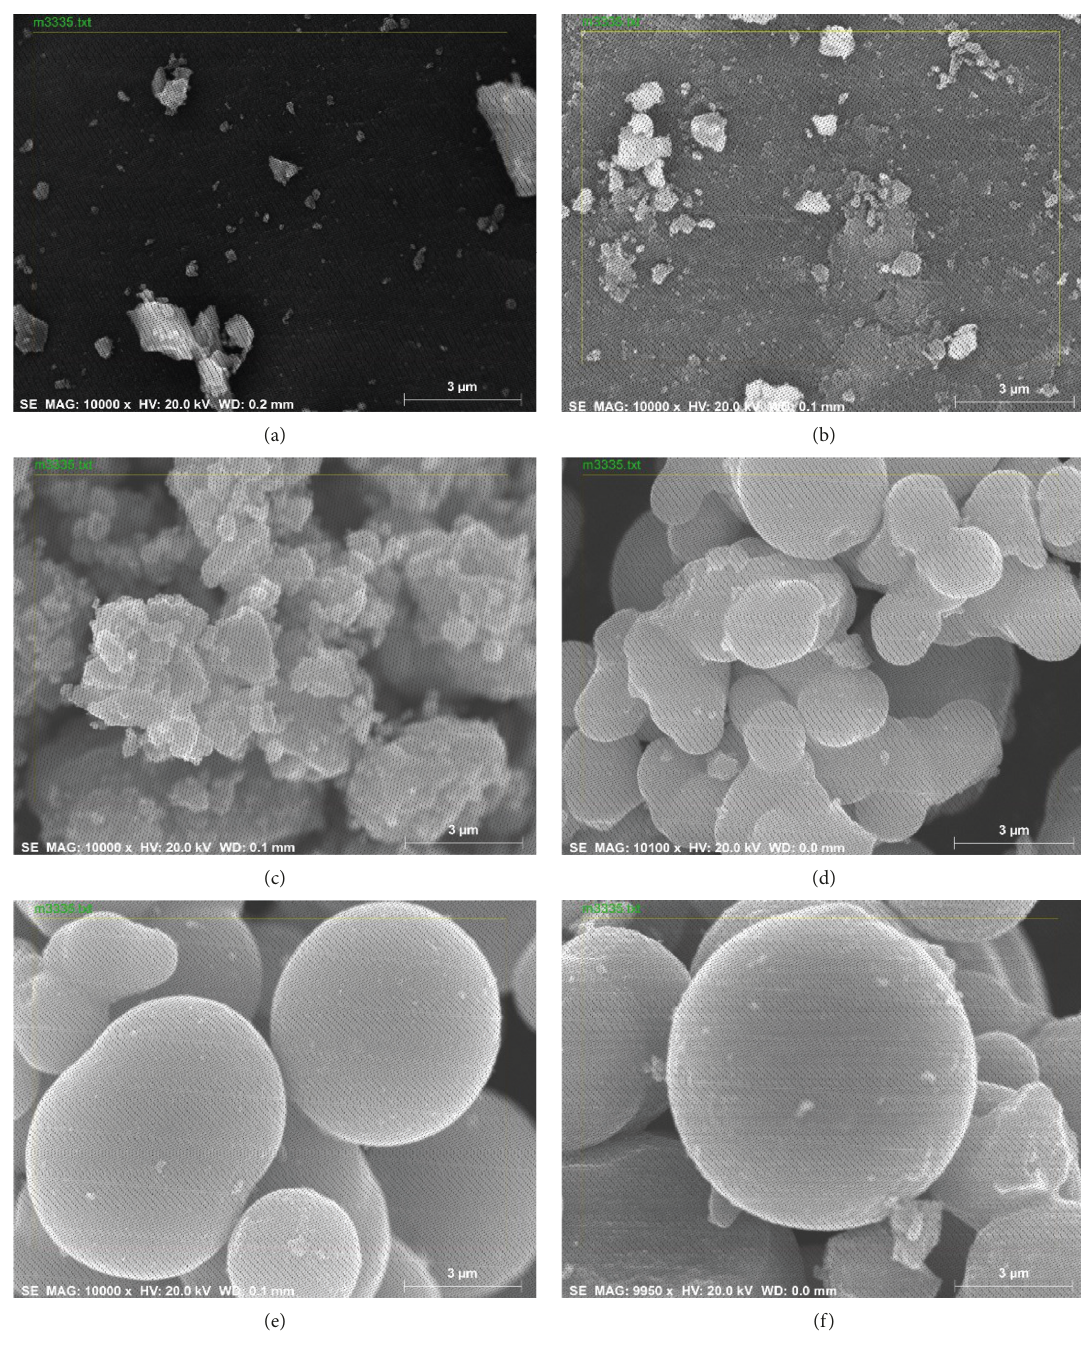
Figure 4: Micrographs of TiO 2m (10,000X magnification) synthesized at different HCl concentrations: (a) 0.5, (b) 1.0, (c) 1.5, (d) 2.0, (e) 2.5%, and (f) 3.0%